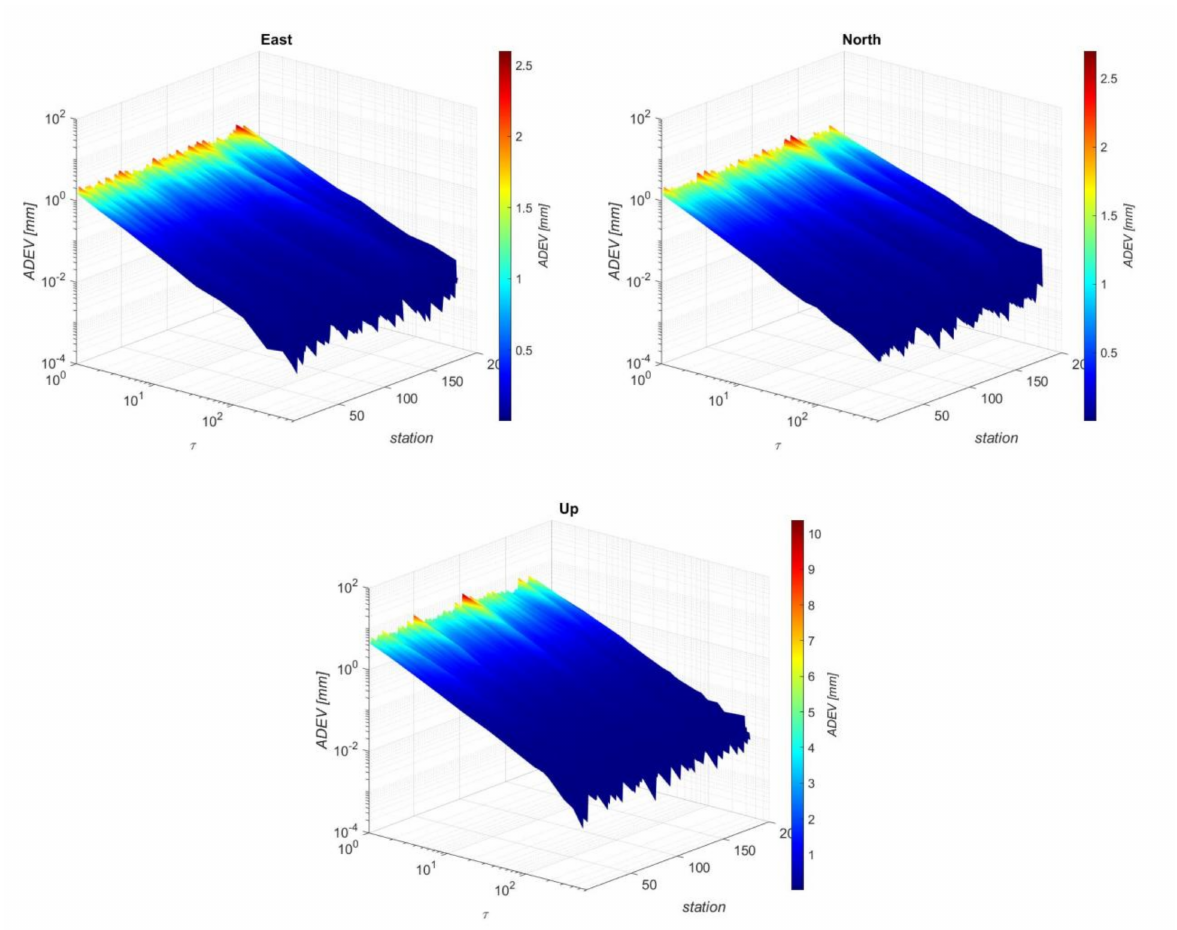
Figure 9. Combined 3D visualisation of the ADEV for all analysed stations. MADEVconfirmsveryhighcohesionofthetimeserieswithinasinglecoordinate